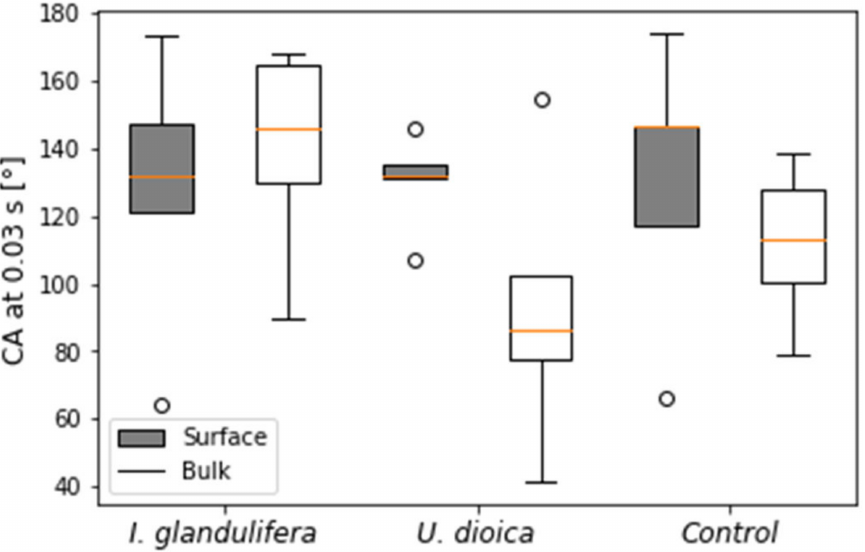
Figure 7. Initial wettability expressed as contact angle after 0.03 s contact time for surface (0–2 cm) and bulk layers (2–5 cm depth) of soil colonized by Impatiens glandulifera ( I. glandulifera ) and by Urtica dioica ( U. doica ) or of bare soil (Control). The boxes present the lower and upper 25th percentiles with whiskers showing the 1.5 fold interquartiles range (IQR) and all data points outside the 1.5 fold IQR depicted as empty